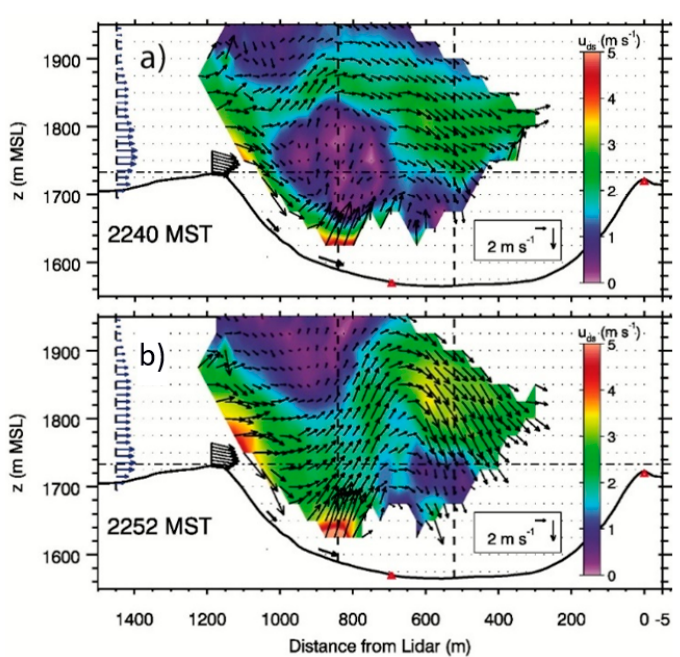
Figure 7. Vertical profiles of horizontal wind in the Neckar valley near the city of Stuttgart in South-Western Germany based on the virtual tower technique. The position of the two Doppler lidars on the slopes performing coordinated scans to place the virtual towers (colored profiles) are indicated by red diamonds. In addition, the horizontal wind profile calculated from a third lidar using the Velocity Azimuth Display (VAD) technique is shown in black. While the flow is rather homogeneous at higher altitudes, some spatial differences occur in lower layers related to the impact of the topography.